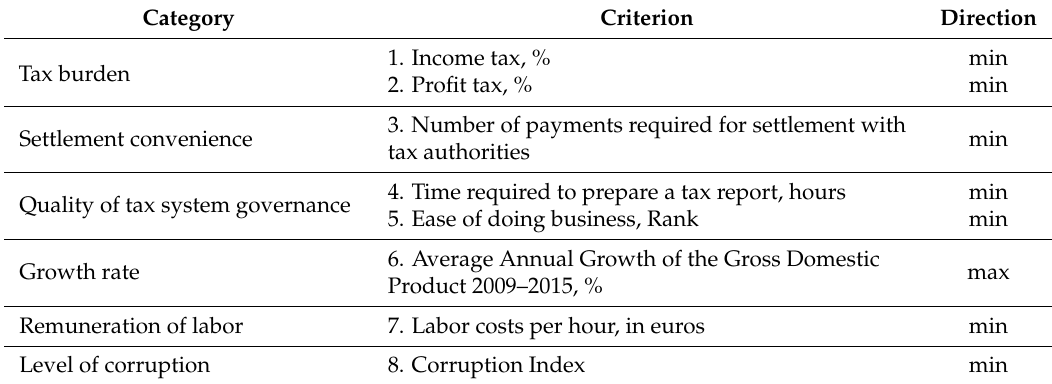
Table 2. Hierarchy structure of the tax competitiveness criteria.